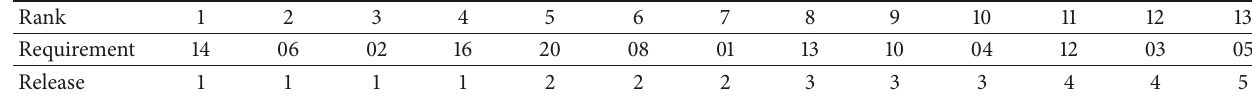
Table 5: Result for file 1 for the VDA methods.